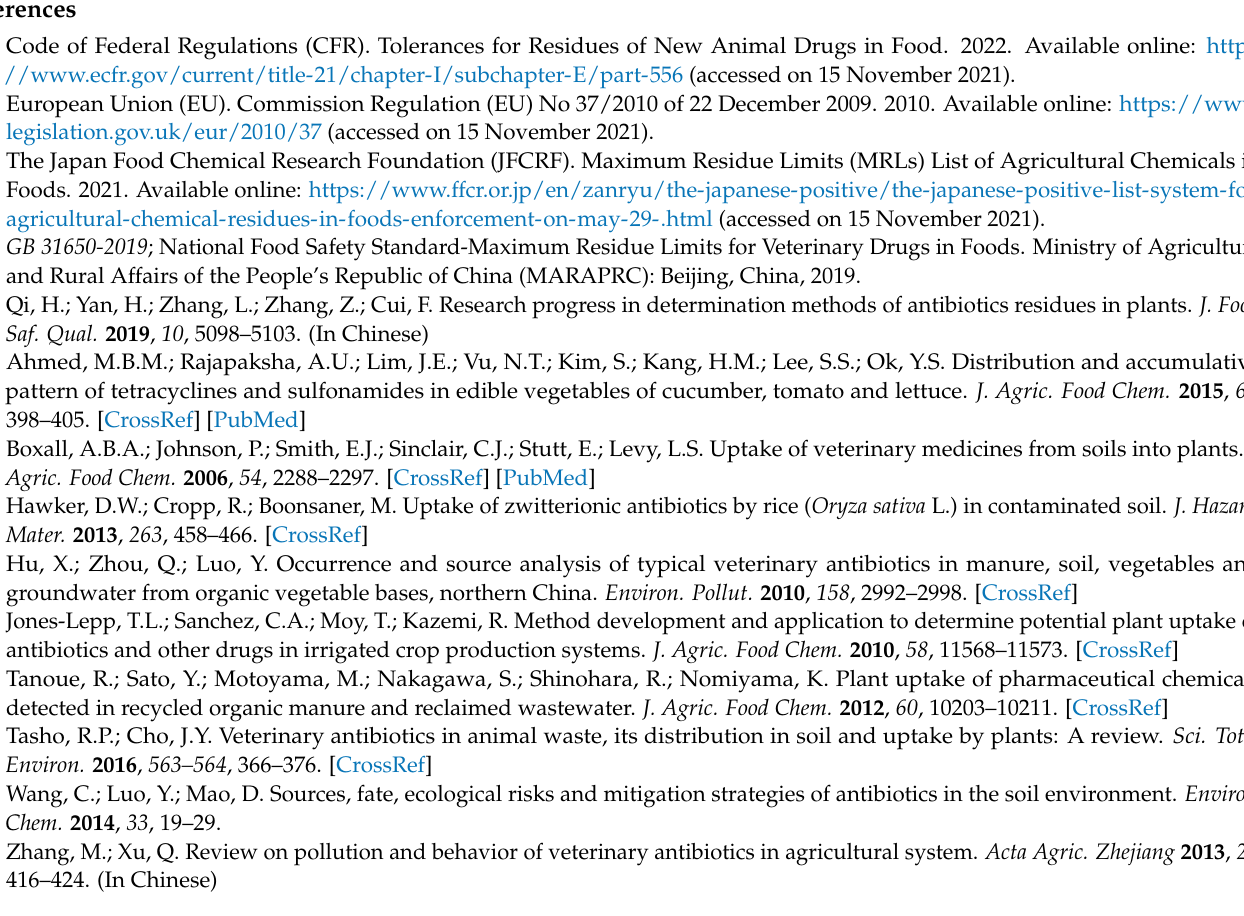
(0~900 s) of spiked maize sample groups on the W4M platform; Figure S2: PCA score plot of spiked maize sample groups; Figure S3: OPLS-DA score plots of spiked maize sample groups; Figure S4: S-plot plots of spiked maize sample groups; Figure S5: Permutation test plots of spiked maize sample groups; Table S1: Recovery (%) of spiked ciprofloxacin-d8 in lettuce sample groups ( n = 9); Table S2: Recovery (%) of spiked ciprofloxacin-d8 in maize sample groups ( n = 9); Table S3: Marker compounds screened in maize sample